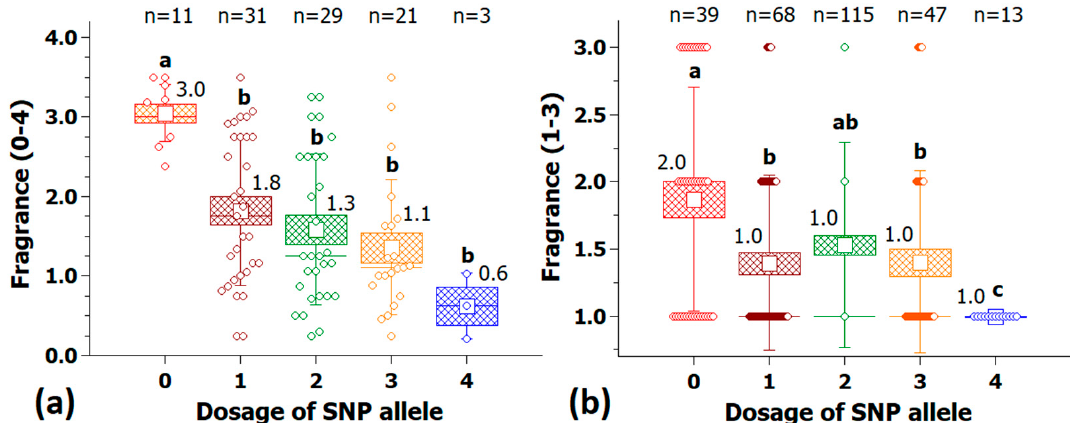
Figure 11. Validation of the KASP marker Rh_FR_SNP201K (Chr 3, 7.3 Mbp) for fragrance with 95 cultivars in the association panel ( a ) and with 282 independent tetraploid cultivars ( b ). On the x -axis are the allelic dosages for the four marker classes (0 and 4 for the homozygote classes and 1–3 for the heterozygotes), and on the y -axis, the fragrance score. For each allele dosage group, the number of individuals (n) is given on top; groups that are significantly different at p ≤ 0.05 are indicated by letters above the whiskers (Kruskal-Wallis rank sum test); median values are given above the box. Small white square = mean; continuous line = median; box = standard error; and whisker = standard deviation.